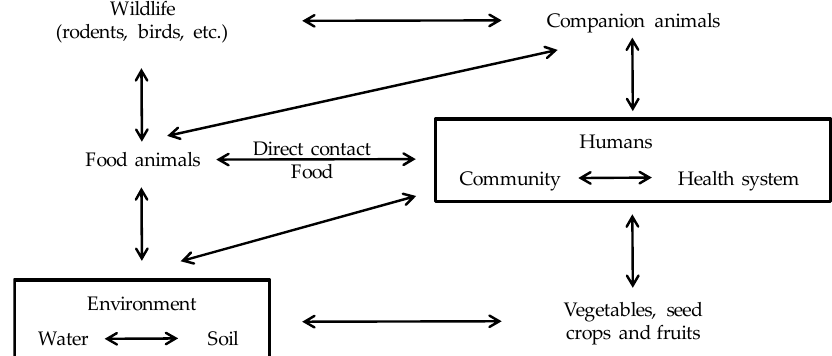
Figure 1. Interactions between groups. Antimicrobial ‐ resistant bacteria can spread to humans either by the food supply, direct contact with food or companion animals or, more indirectly, through environmental pathways, including waterways, soils and vegetables contaminated with human or animals waste, and vectors such as rodents, insects, and birds. Based on da Costa et al. [8] and McEwen et al. [9] with modifications.